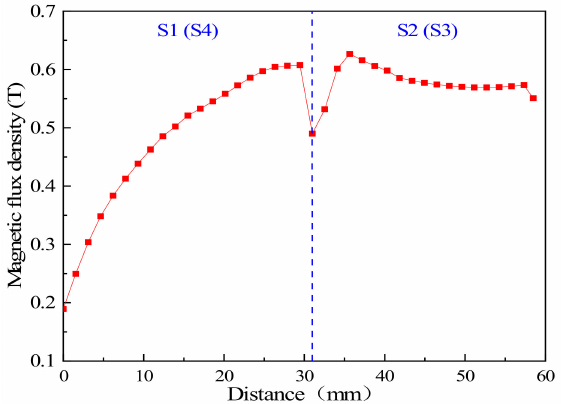
Figure 8. Variation of magnetic flux density along